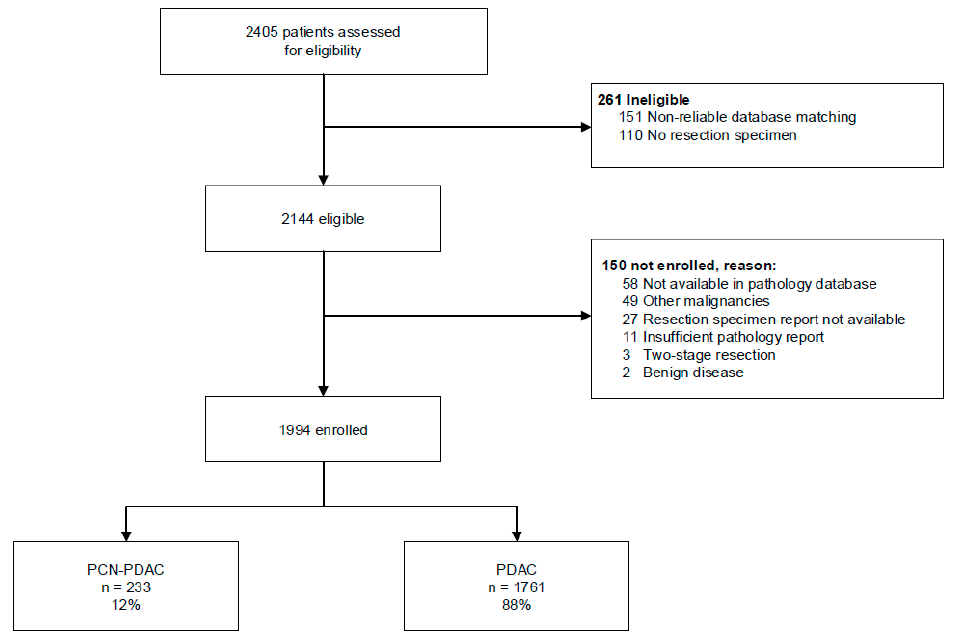
Figure 1. Study design. Abbreviations: PCN = pancreatic cystic neoplasms. PDAC = pancreatic ductal adenocarcinoma. Table 1. Baseline and tumor characteristics.